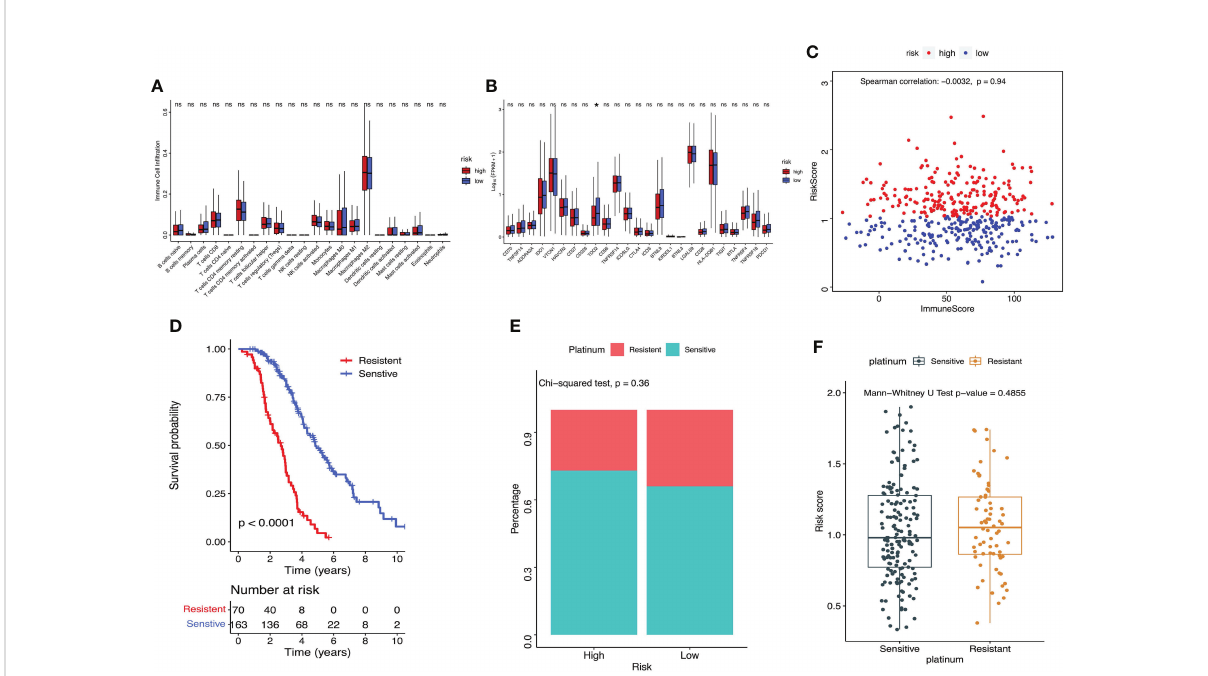
FIGURE 7 Assessment of the immuno ‐ /chemotherapeutic response in the risk subtypes for ovarian cancer patients in the TCGA dataset. (A) Proportion of immune cell in fi ltration in TME between high- and low-risk groups. (B) Expression of immune checkpoints between high- and low-risk groups. (C) ESTIMATE calculated the correlation between the prognostic risk signature and immune score. (D) K-M survival curve of platinum-sensitive and platinum-resistant patients. (E) Percentages of platinum sensitivity in high- and low-risk groups. (F) Risk scores of platinum-sensitive and platinum-resistant patients. *P < 0.05. ns, no signi fi